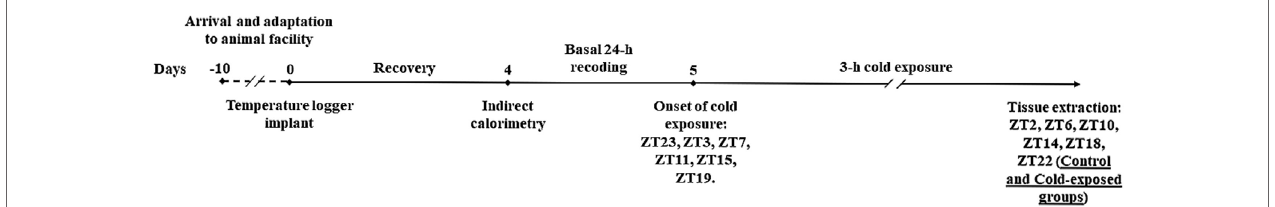
FigUre 1 | Graphical representation of experimental